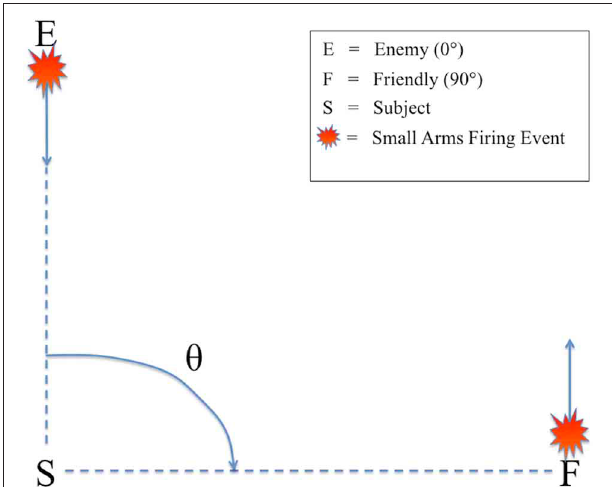
FIGURE 2 | Schematic of the simulated small arms fire localization task. θ denotes the angle of incidence between the subject (S) and the firing event as conveyed by audio recording. Firing events from θ = 0 ◦ were labeled “enemy” (E) and θ = 90 ◦ were labeled “friendly” (F). Subjects were instructed to identify the angle of incidence of the firing event from these two possible choices as quickly as